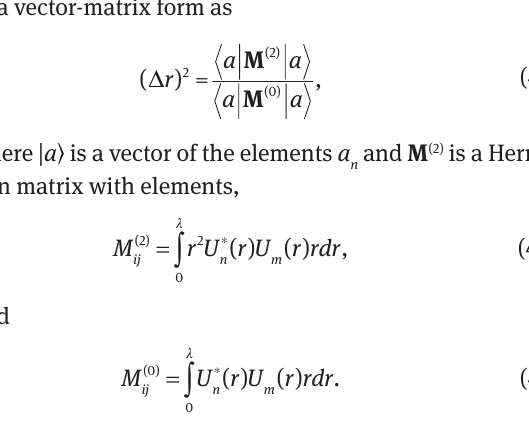
modes with N total n 0